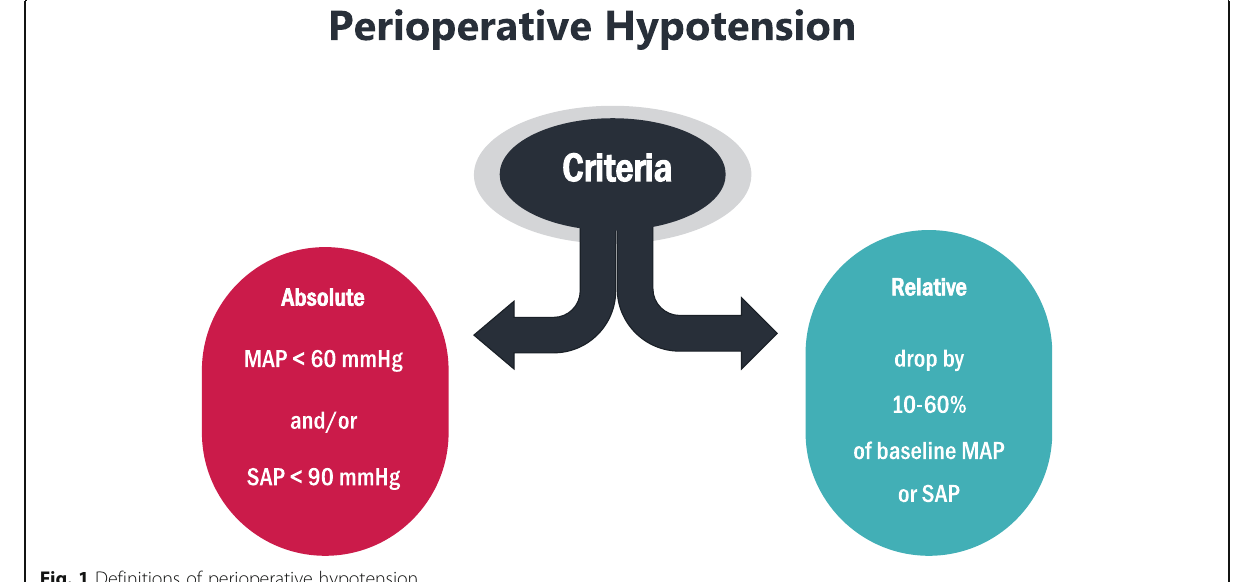
Fig. 1 Definitions of perioperative hypotension